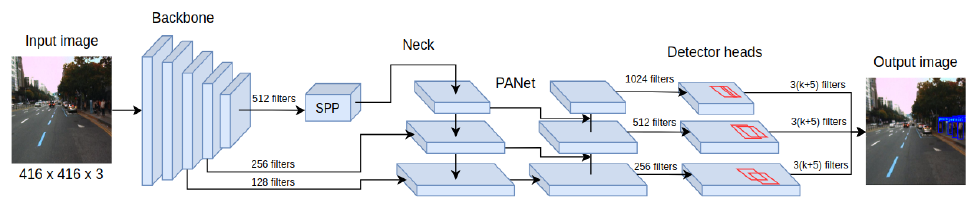
Figure 1. Scheme showing the main processing components of the YOLOv4 detector